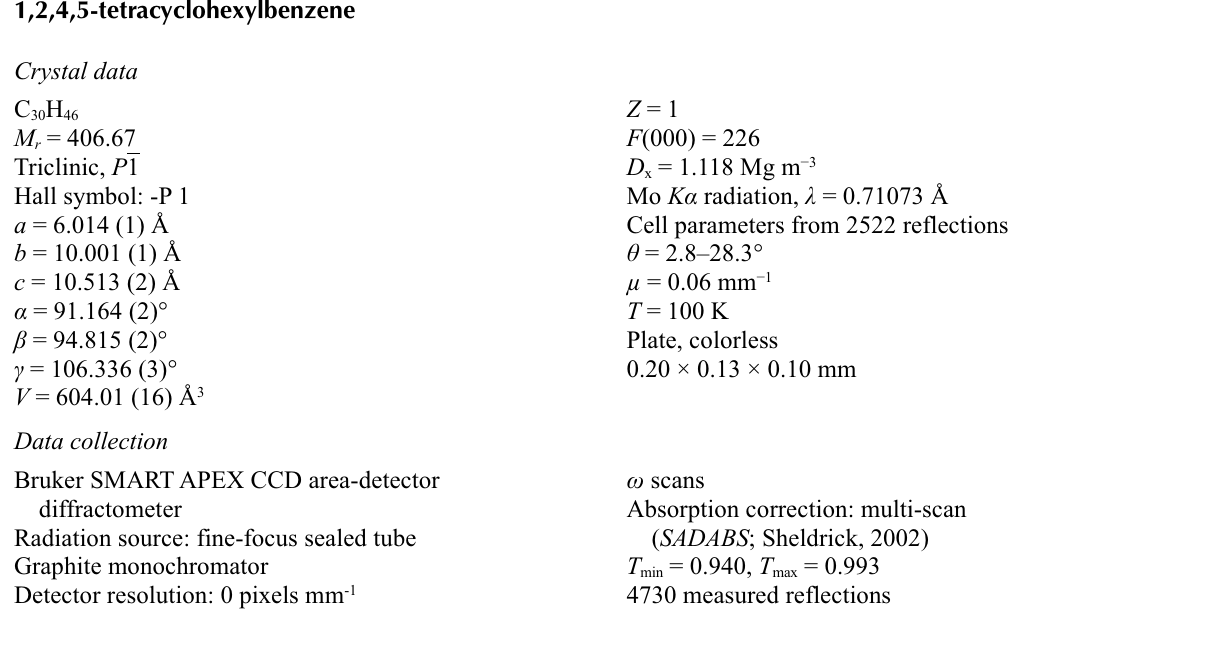
Molecular structure of the title compound. Displacement ellipsoids are drawn at the 50% probability level and H-atoms are represented by spheres of arbitrary radius. Primed atoms are related to unprimed atoms by the symmetry operation - x , 1 - y , - z